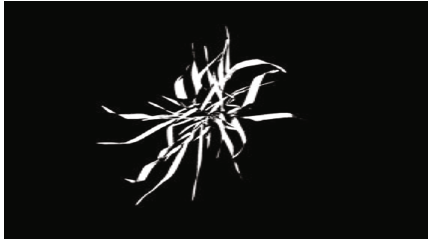
Figure 9: Segmentation algorithm used: C fi tK-means; description: best